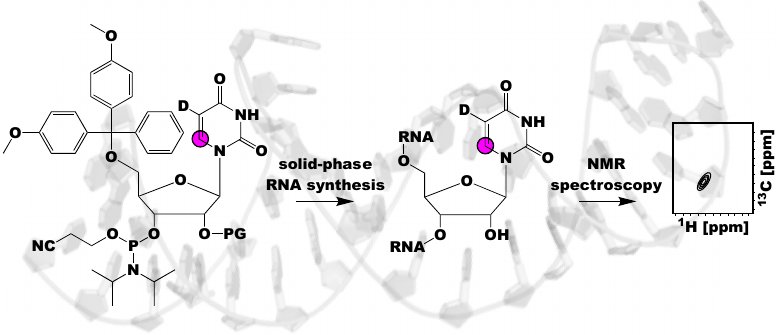
Figure 1. Schematic of the utility of using isotope labeled RNA phosphoramidites and solid-phase synthesis to investigate RNA structure and dynamics. This methodology incorporates labels site-specifically into RNA, resolving NMR spectral overlap and ambiguities in NMR spectra interpretation. Magenta circle indicates a 13 C atom, D indicates a 2 H atom, and PG refers to a 2 (cid:48) -OH protecting